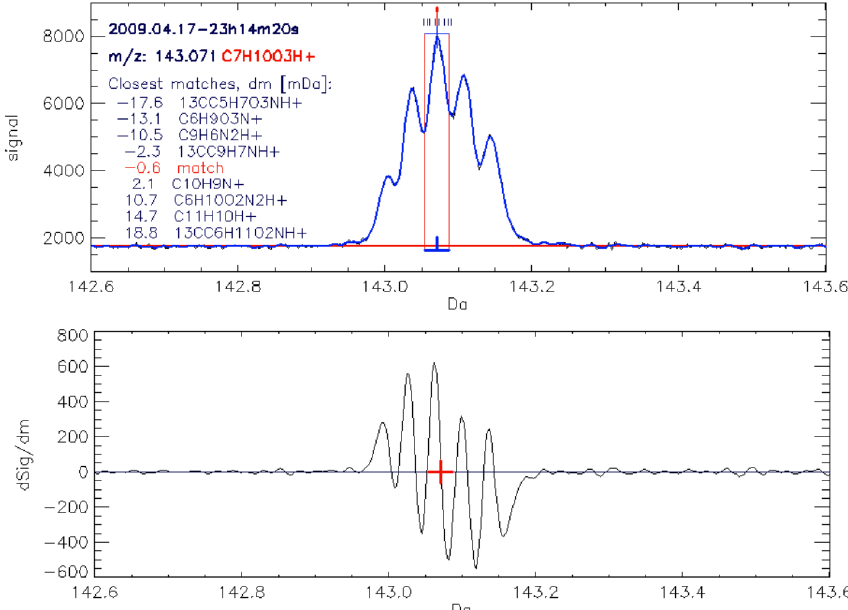
Figure 1. A small section of Spec (upper chart, smoothed in blue, unsmoothed SumSpectrum in black) and dSpec (lower chart). The baseline signal (Sect. 2.1.3) is plotted as red line in the upper chart. The peak search routine detected five peaks at 143.002, 143.036, 143.071, 143.105, and 143.142, respectively. The range “PeakStart” to “PeakEnd” is indicated by two horizontal blue lines above the x axis and in the upper chart area, respectively. The blue ticks on these lines mark the position of “PeakMax”. The vertical red lines in the upper chart indicate the integration boundaries (Sect. 2.1.6.) that correspond to a range of ± 2 σ of the quasi-Gaussian peak shape (Sect. 2.1.4.). The black and red ticks above the selected peak in the upper chart correspond to ion masses of the closest matches in the compound library (see masslib function in Appendix C). The largest peak at 143.071 has been matched to C 7 H 10 O 3 H + ; other compounds in the vicinity are plotted in the chart area together with their deviation from the detected